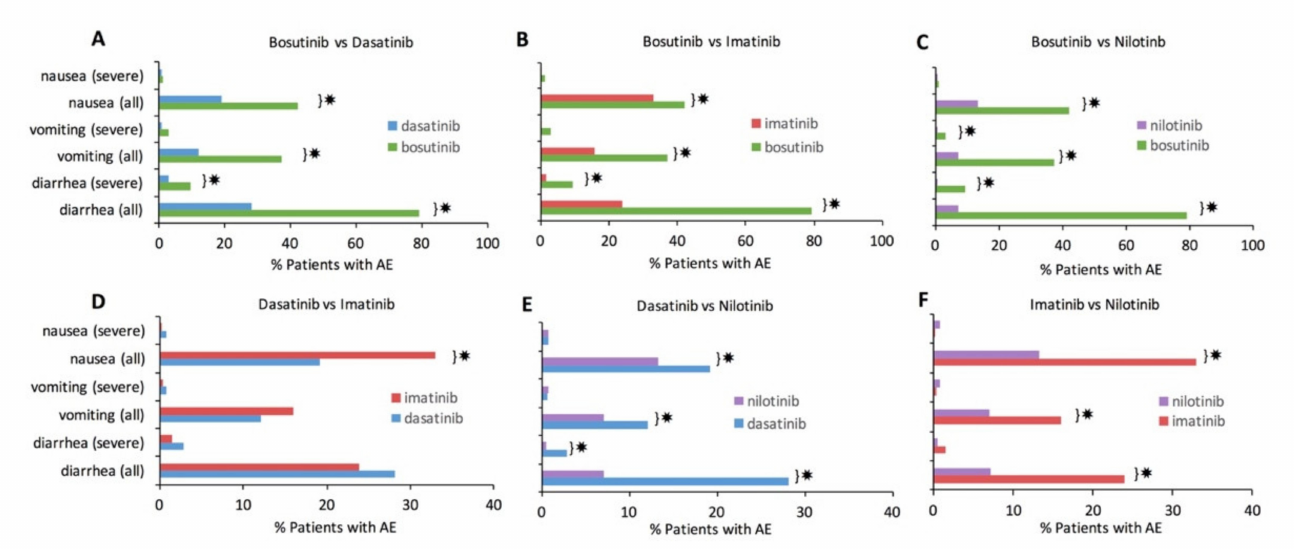
Figure 2. Pairwise statistical comparison of gastrointestinal adverse events (GI AEs) for each included tyrosine kinase inhibitor (TKI), including bosutinib, dasatinib, imatinib, and nilotinib. Each TKI is compared to every other TKI using z-test for the population proportion. p -value threshold for significance was adjusted for multiple comparisons using the Bonferroni correction, resulting in a significant p -value being <0.00016, which is indicated by ✸ . ( A ). Bosutinib compared to dasatinib. ( B ). Bosutinib compared to imatinib. ( C ). Bosutinib compared to nilotinib. ( D ). Dasatinib compared to imatinib. ( E ). Dasatinib compared to nilotinib. ( F ). Imatinib compared to nilotinib.